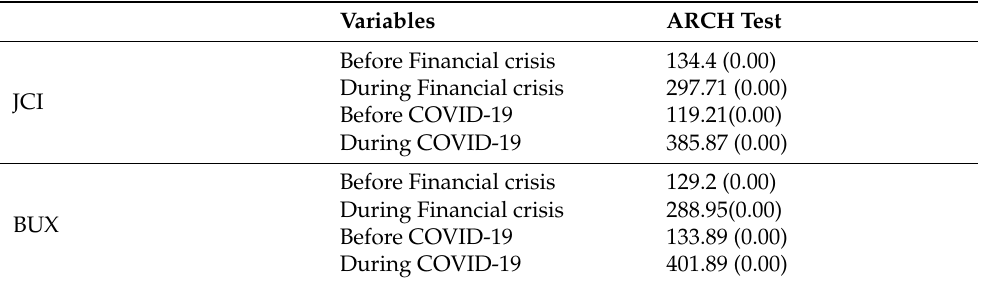
Table 7. ARCH test